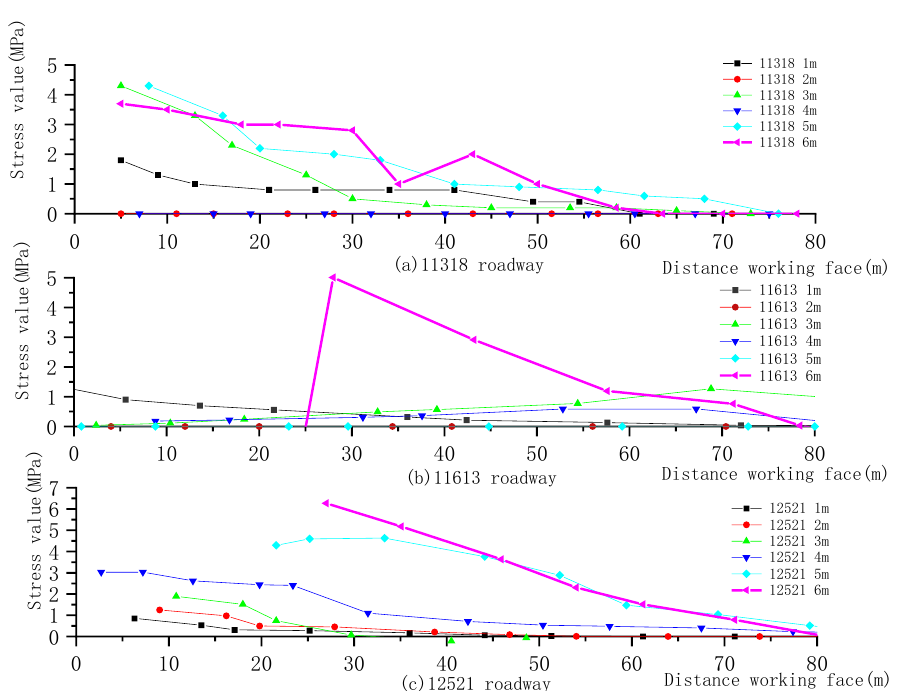
Figure 13. Contrast analysis diagram of high side vertical stress. ( a ) 11318 roadway; ( b ) 11613 roadway; ( c ) 12521 roadway.